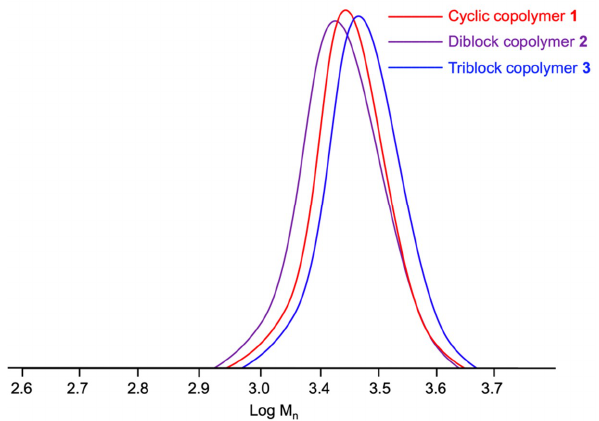
Figure 1. Gel permeation chromatography (GPC) traces of copolymers 1 , 2 , and 3. Table 1. Comparison of the properties of copolymers 1 , 2 , and 3.